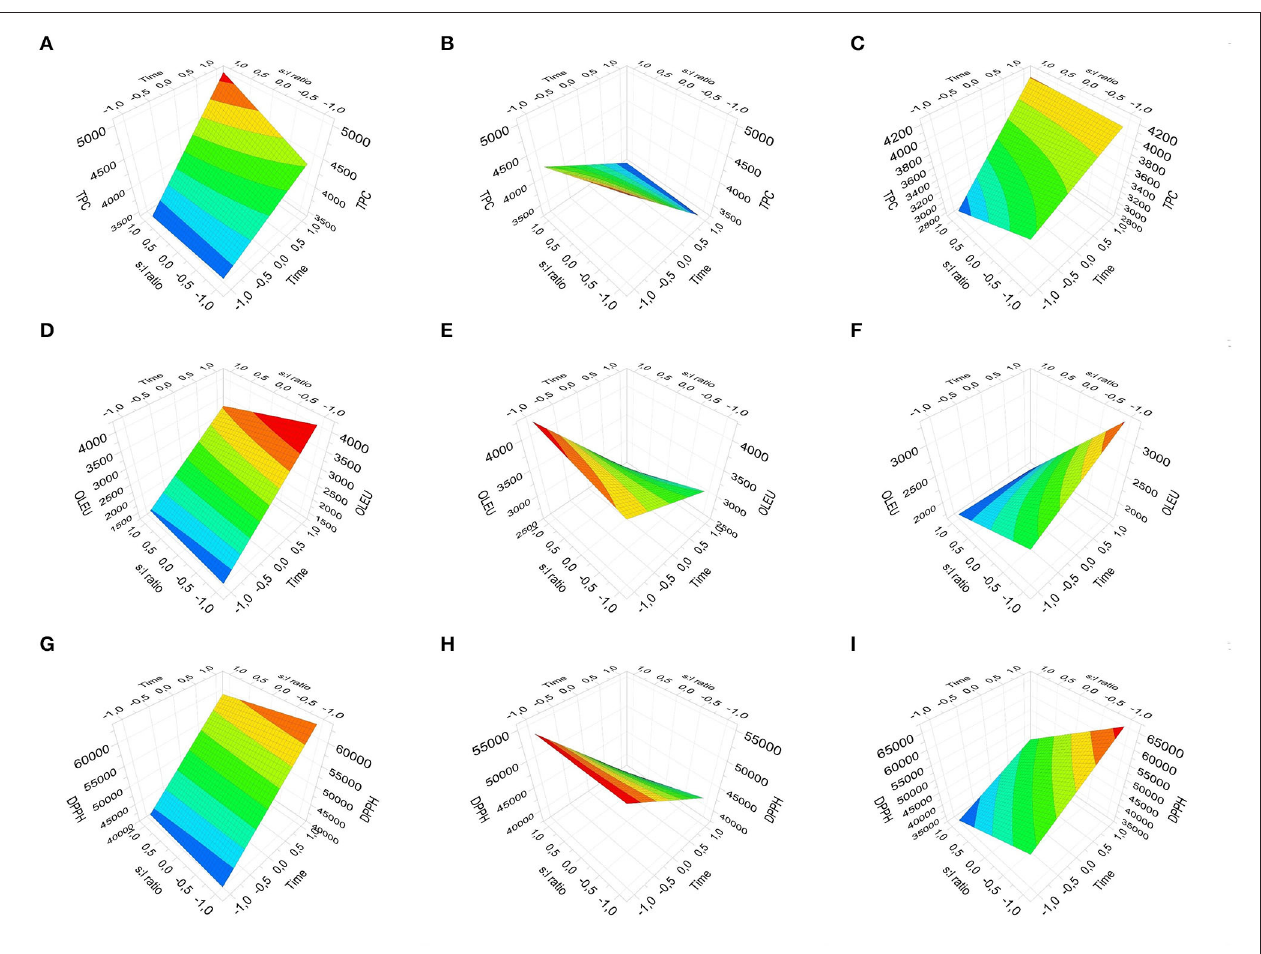
FIGURE 4 | Response Surface Plot for the three responses: TPC by CE, HAE, and UAE (A–C) , OLEU concentration by CE, HAE, and UAE (D–F) , and DPPH assay by CE, HAE, and UAE (G–I)